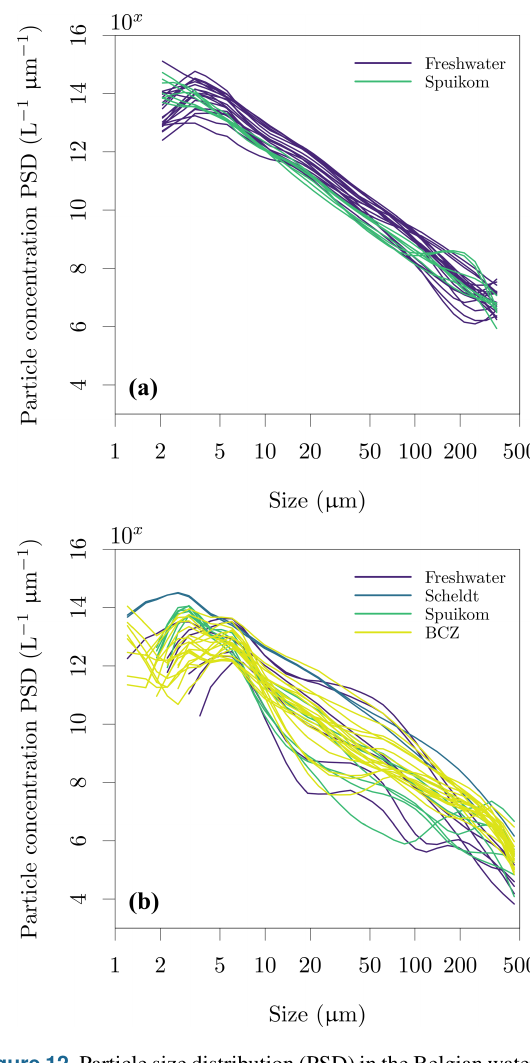
Figure 12. Particle size distribution (PSD) in the Belgian water sys- tems. (a) Retrieved with the LISST-100X and (b) retrieved with the LISST-200X. The continuous particle number concentration PSD was calculated from the volume concentration PSD assuming spher- ical particles of median diameter in each size bin and normalising by the width of each logarithmically spaced size